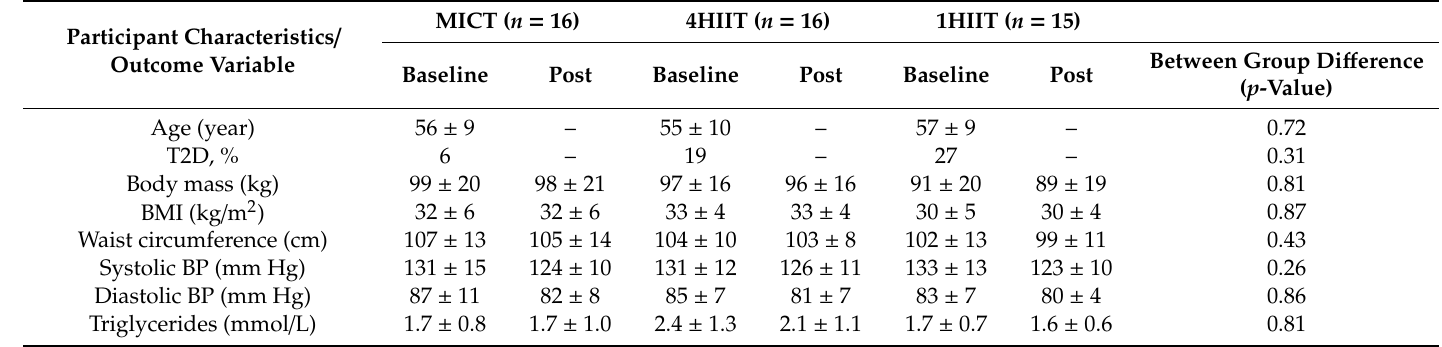
Table 2. Participants not taking